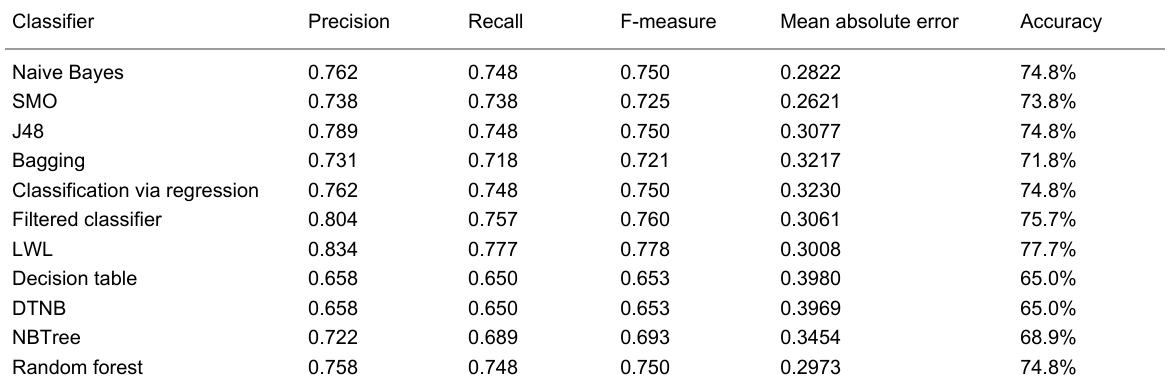
Table 3: Results from the 10-fold cross-validation listed by classifier for the third analysis including the molecular descriptors selected by experts. See Equation 1–4 for the definition of precision, recall, F-measure, and mean absolute error and accuracy.